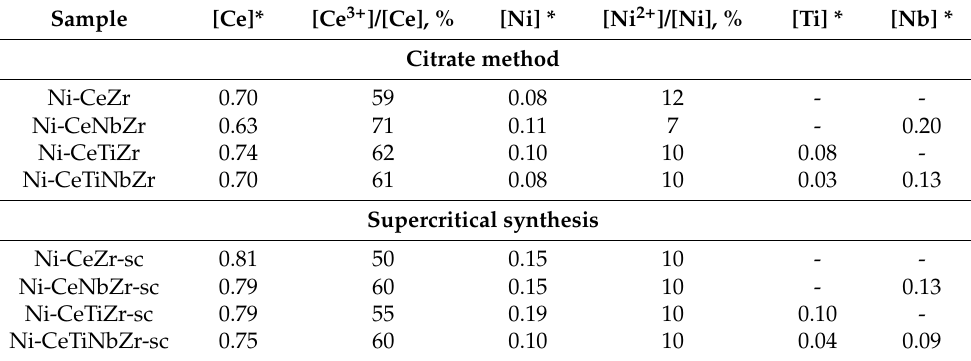
Table 3. Atomic ratios of elements in the (sub)surface layers of catalysts after reduction treatment in H 2 at 450 ◦